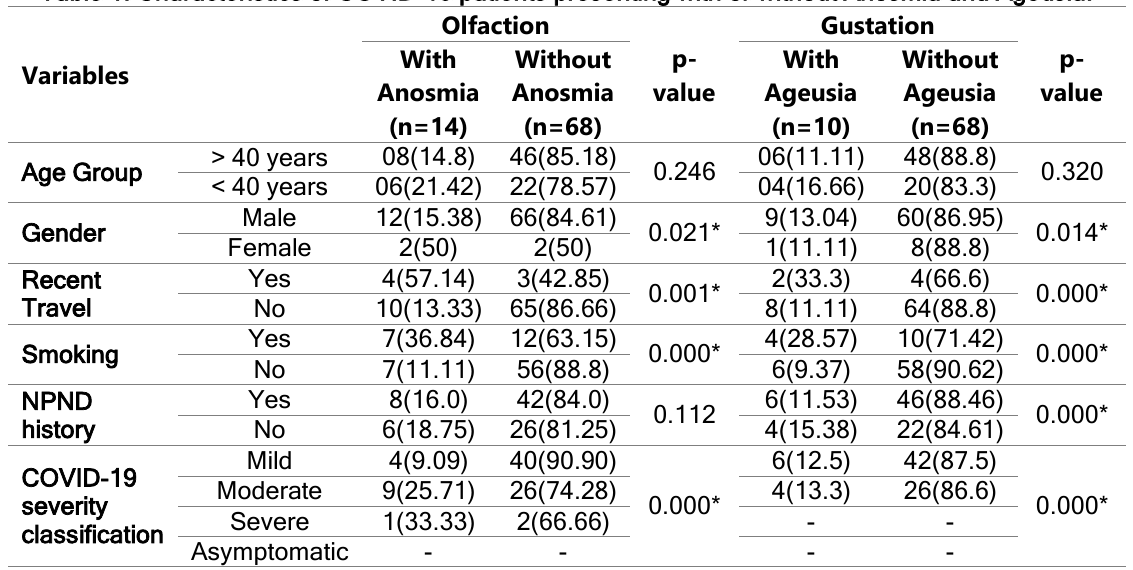
Table 1: Characteristics of COVID-19 patients presenting with or without Anosmia and